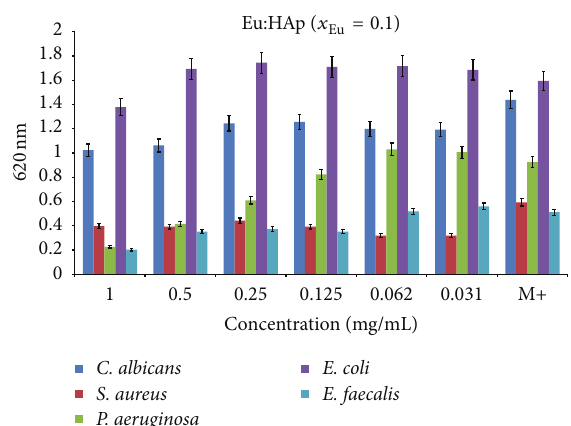
Figure 5: Antimicrobial activity of as-prepared Eu:HAp samples = 0.1 ) on E. coli ATCC 25922, Pseudomonas aeruginosa 1397, ( 𝑥 Eu Staphylococcus aureus 0364, Enterococcus faecalis ATCC 29212, and Candida albicans ATCC 10231.